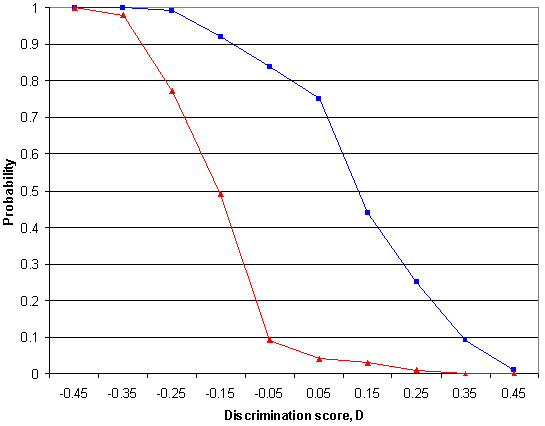
Probabilities used for development of a calibrated score. Probability (y-axis), p(D'≥D), for observing a score D' greater than or equal to D (x-axis) for either bbtm (■) or ntm (▲) proteins. Plots were made by calculating the frequencies of bbtm and ntm proteins identified above certain discrimination scores (using weighted amino acids, no evolutionary information and a 'leave homologues out' cross-validation).